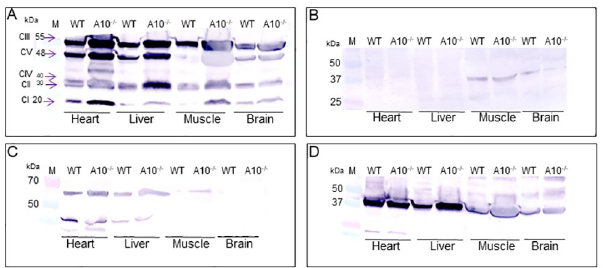
Fig 1. Western blot survey of ETC subunits and ACADs in mouse heart, liver, muscle, and brain. A 4–15% SDS-PAGE gel with 50 μ g of tissue extract applied per lane was visualized by western blotting with antiserum to the indicated protein. (A) Mitochondrial protein subunits complex III (55 kDa), complex V (48 kDa), complex IV (40 kDa), complex II (30 kDa), and complex I (20 kDa) were visualized in heart, liver, muscle, and brain using a mitochondrial cocktail antibody. (B) Immunostaining for citrate synthase revealed a 37 kDa band. Western blots using anti VLCAD (C) and MCAD (D) antisera showed the appropriate protein sizes of 62 kDa and 42 kDa, respectively.